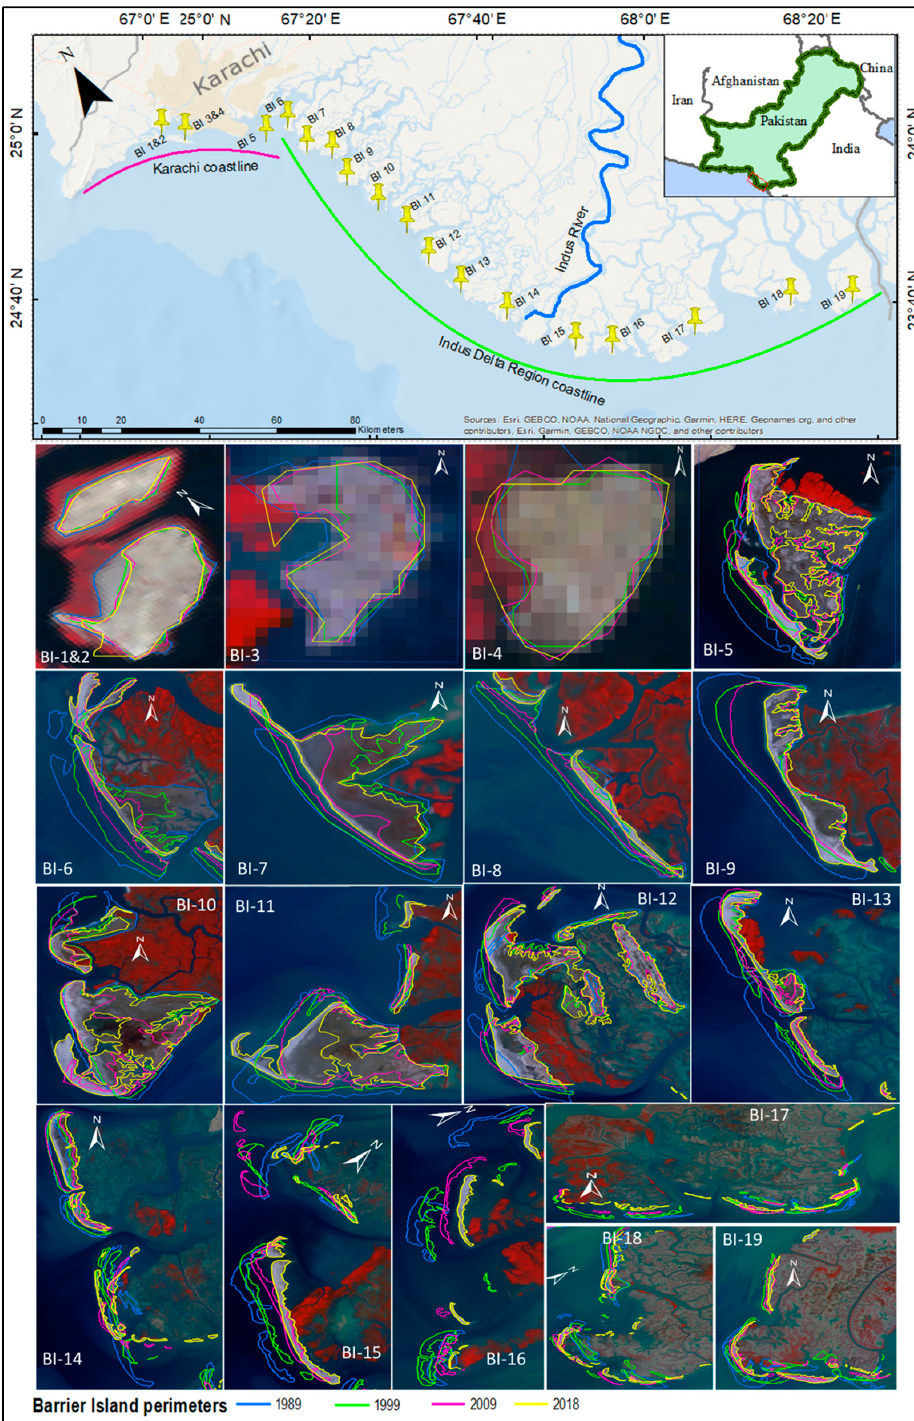
Figure 3. Multitemporal shoreline maps of the BIs along the coast of Sindh (i.e., Karachi shoreline (pink arc) and Indus Deltaic Region (IDR) shoreline (green arc)) during the period 1989–2018. BI segmentation is visible for many islands.